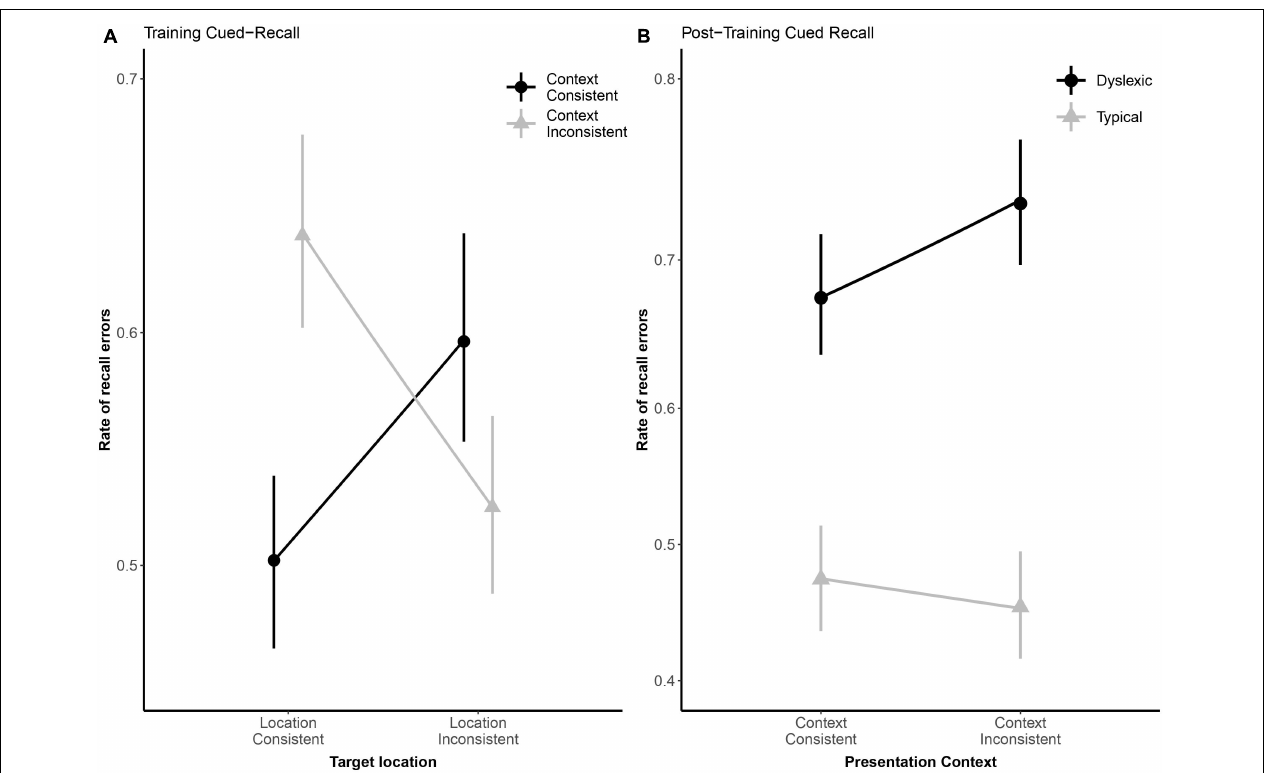
FIGURE 5 | Panel (A) shows subject-weighted mean recall error rate as a function of context and location consistency in the cued-recall trials interspersed in training. Panel (B) shows subject-weighted mean recall error rate as a function of reading ability and context consistency in the post-training cued-recall test. In both panels, the y -axis is logit-scaled to match logistic regression error analyses. Point ranges represent bootstrapped confidence intervals, and lines represent logistic regression model